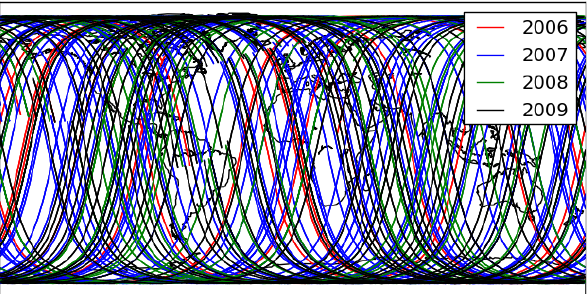
Fig. 1. Total global coverage of 99 matched CALIPSO-NOAA- 18 orbits in the period October 2006 to December 2009. Different colours refer to different